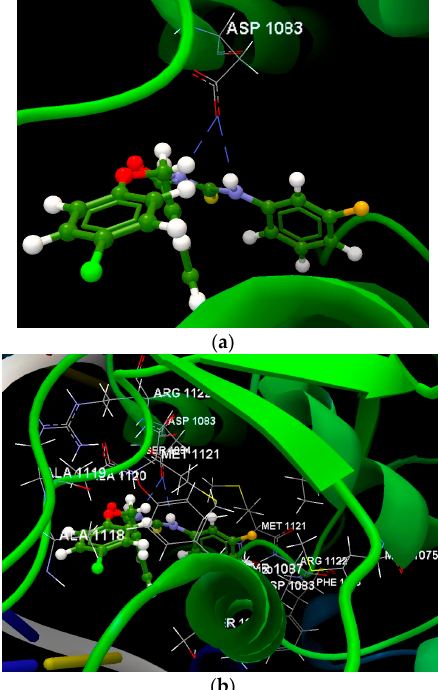
Figure 8. ( a ) The hydrogen bonds between the amino acid residue of the ASP 1083(D) and the compound 1a was displayed in dashed blue lines. ( b ) Docking pose of the 1a ligand interacting with amino acids residues.